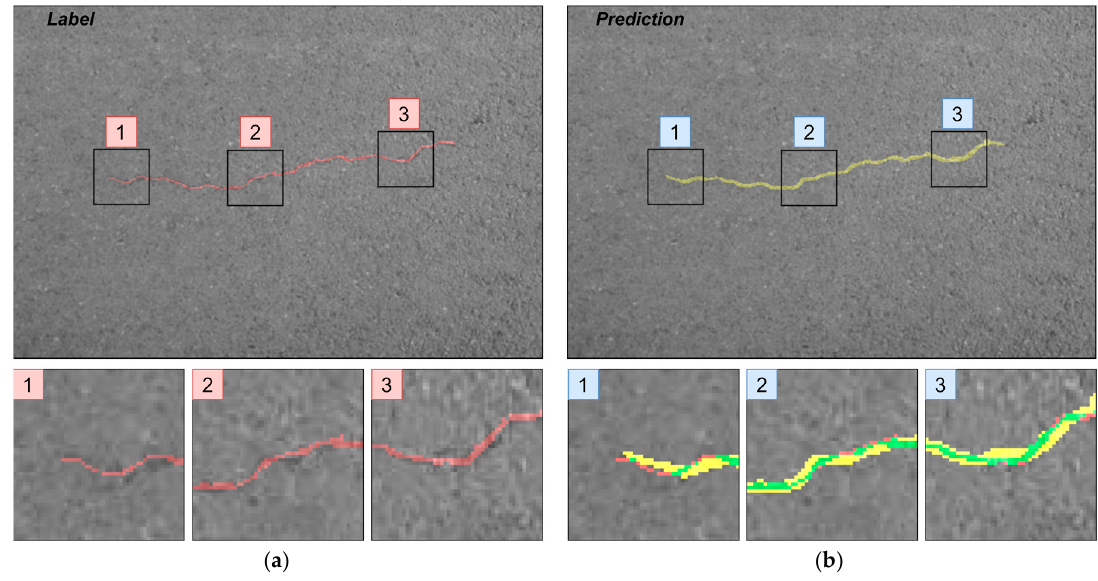
Figure 17. ( a ) Label and ( b ) prediction of U-Net rendered on images from CrackForest and zoomed regions. Green, overlap of label and prediction; red, prediction pixels; yellow, prediction pixels. Table 3. Performance evaluation with the 0, 2-, and 5-pixel tolerance on the baseline (U-Net) and best-performing architectural solutions in every